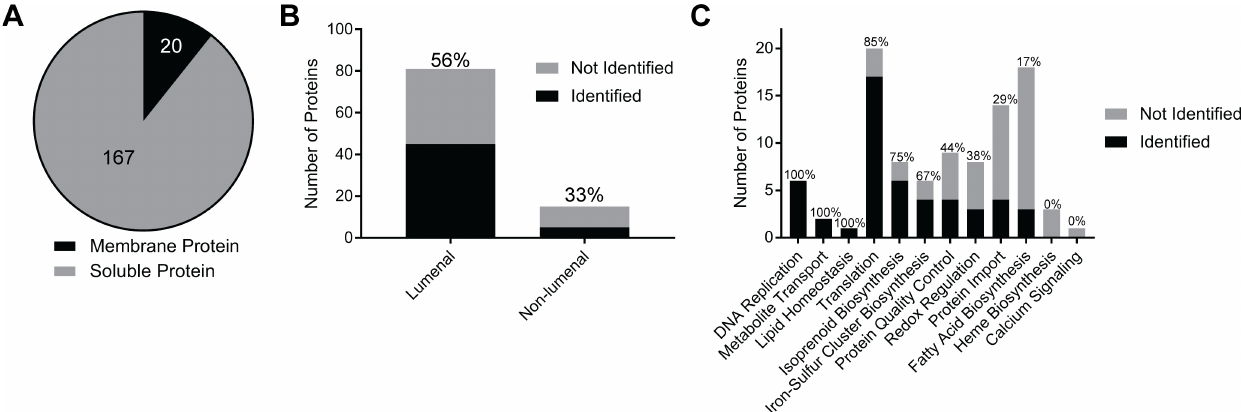
Fig 3. Diversity of protein labeling by apicoplast BioID. (A) Fraction of proteins identified by apicoplast BioID that are predicted to localize to a membrane. Proteins were considered “membrane” if they had at least 1 transmembrane domain annotated in PlasmoDB ending > 80 amino acids from the annotated N -terminus. (B) Number of lumenal and nonlumenal positive controls identified. Percentages above bars indicate the percentage of known proteins from each category identified. (C) Number of proteins from established apicoplast pathways identified. Percentages above bars indicate the percentage of known proteins from each pathway identified. Tabulated data are available in S1 Data. BioID, proximity-dependent biotin identification.